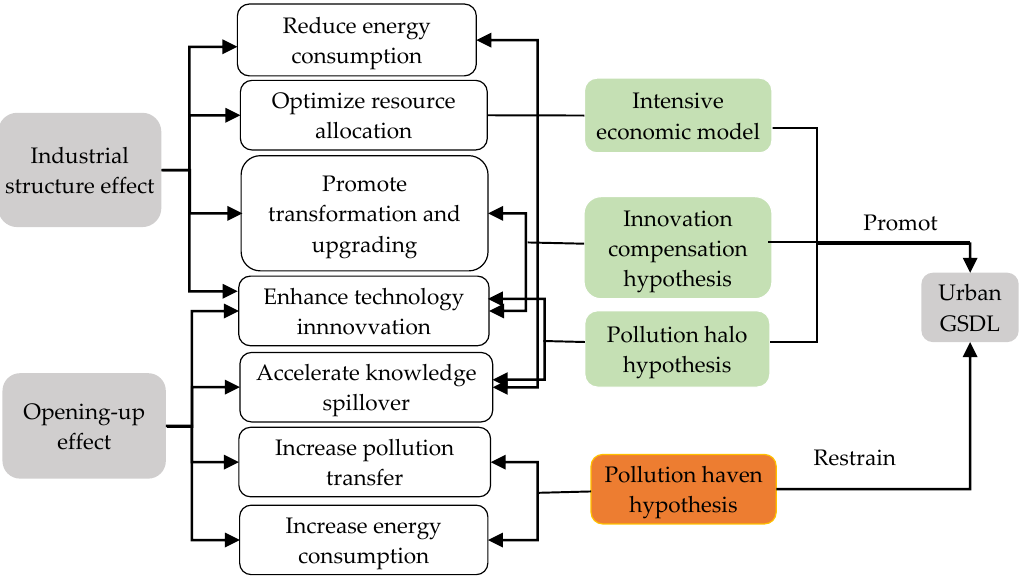
Figure 7. Theoretical mechanism diagram of influencing factors on the urban GSDL